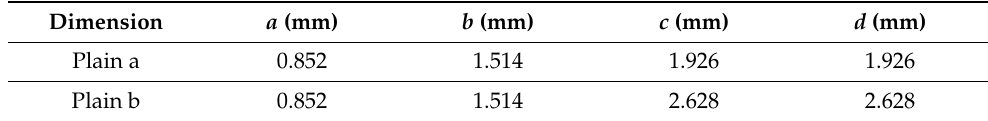
Table 1. The geometry parameters of the specimens. Dimension a (mm) b (mm) c (mm) d (mm) Plain a 0.852 1.514 Plain